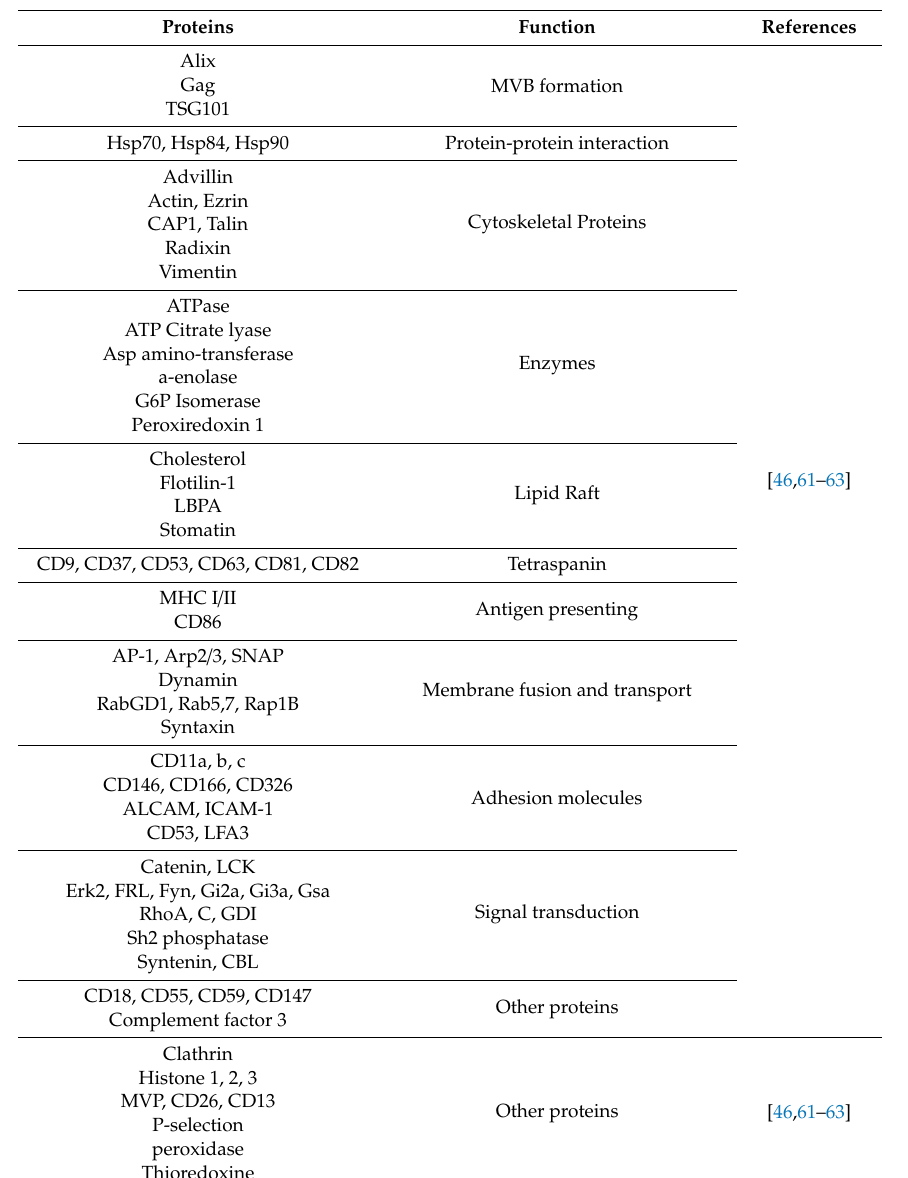
Table 1. Main EEV membrane